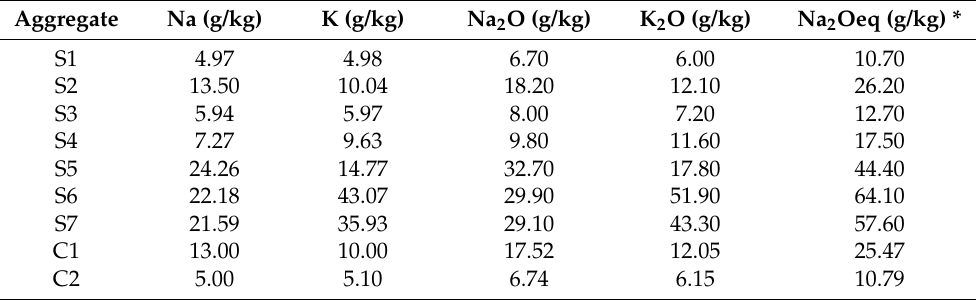
Table 2. Contents of sodium and potassium of aggregates investigated.